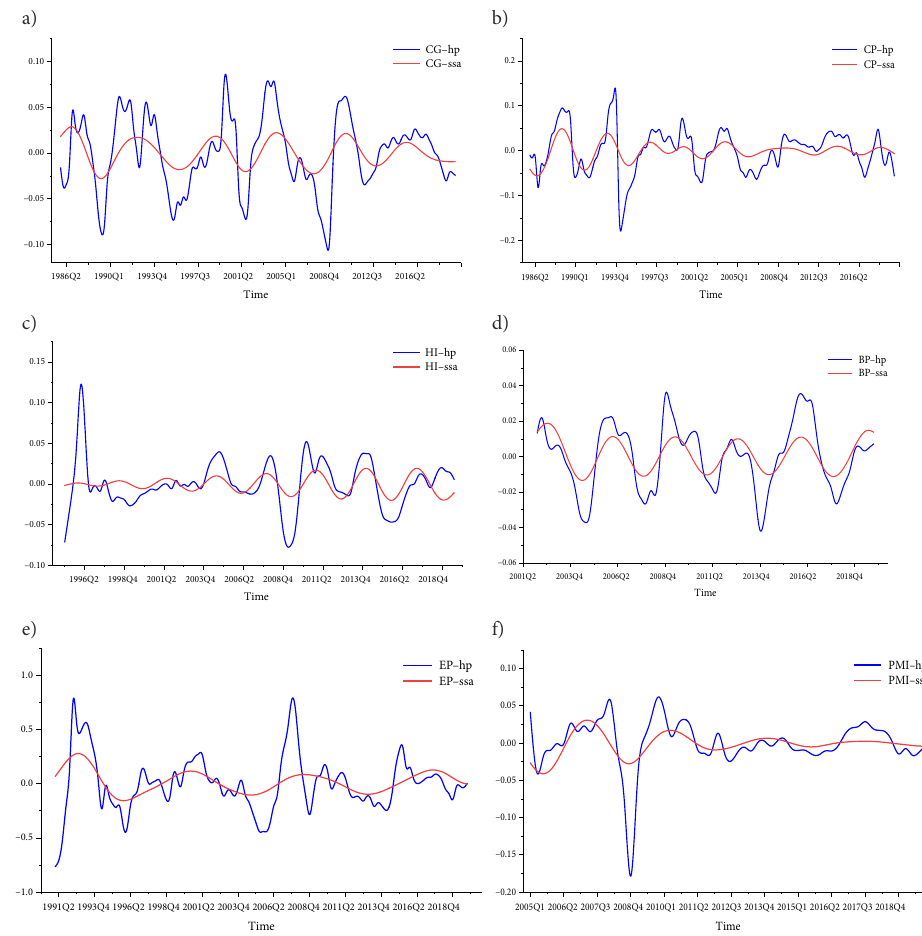
Figure 4. Financial cycles in China for CG , CP , HI , BP , EP and PMI (source: authors’